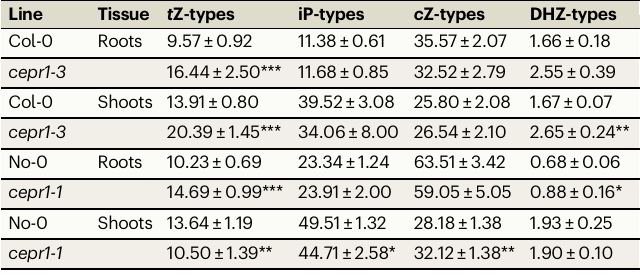
Table 1 | Total cytokinin content in roots and shoots of wild type and cepr1